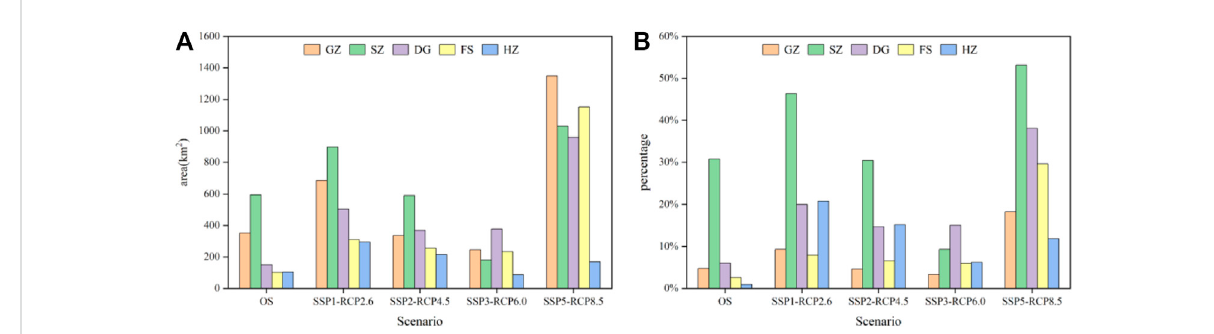
FIGURE 8 Area and percentage of the highest risk zone in cities under the original scenario and the scenarios in 2030. GZ, Guangzhou city; SZ, Shenzhen city; DG, Dongguan city; FS, Foshan city; HZ, Huizhou city. Note: (A) Percentage of the highest risk zone in cities under the original scenario and the